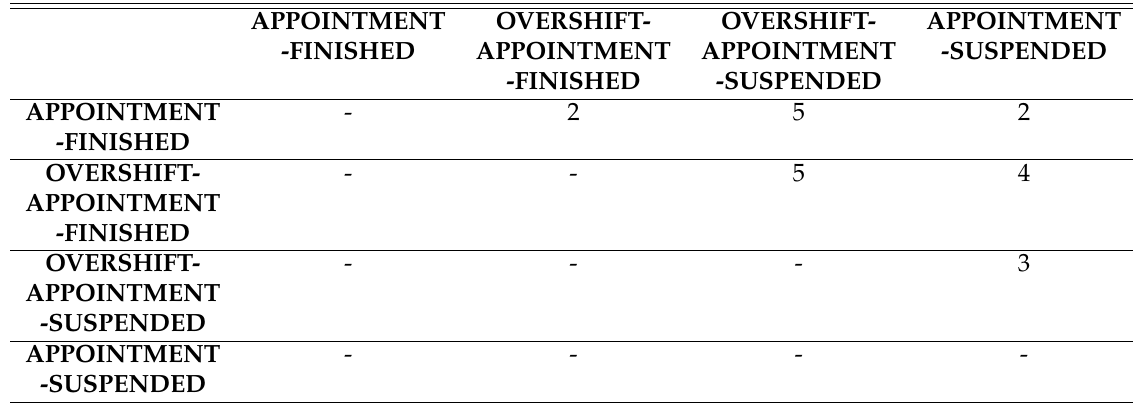
Table 5: Matrix of distances between elements